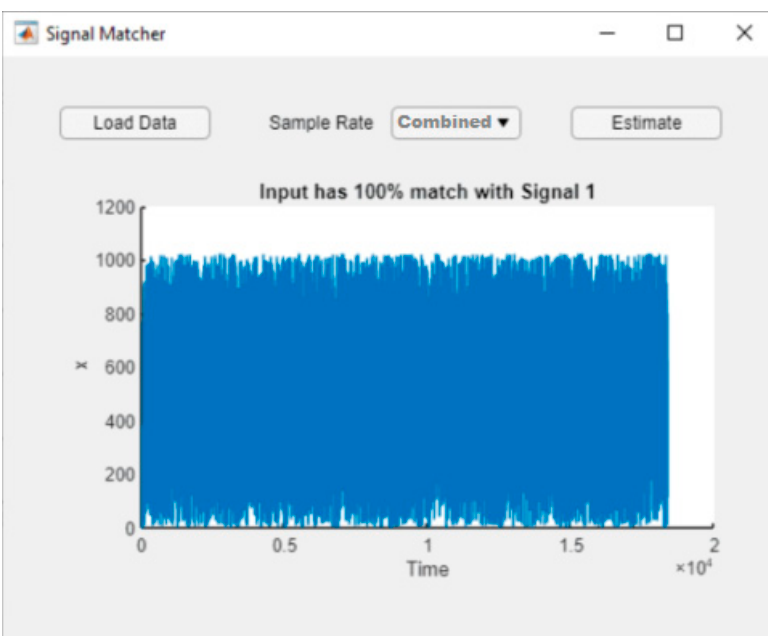
Figure 15. Comparison result of P4 (Combined output).